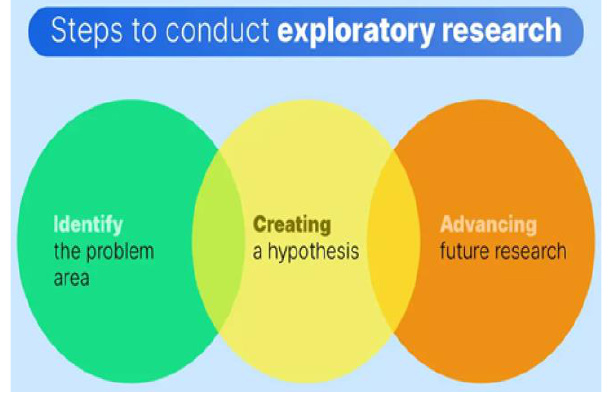
Figure 2. Exploratory research steps.